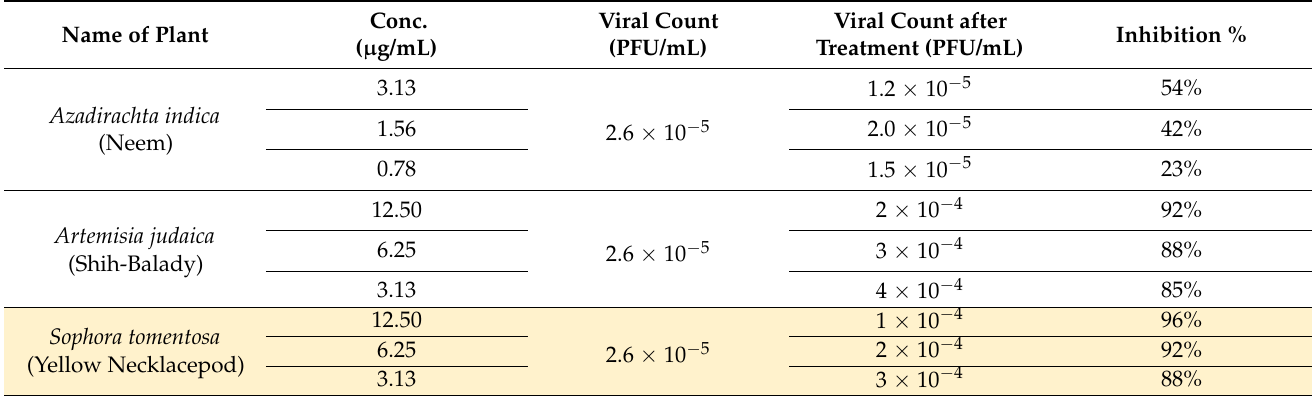
Table 1. Antiviral activity of three medicinal plants using plaque reduction assay against the MERS- CoV isolates (NRCE-HKU270 (Accession Number: